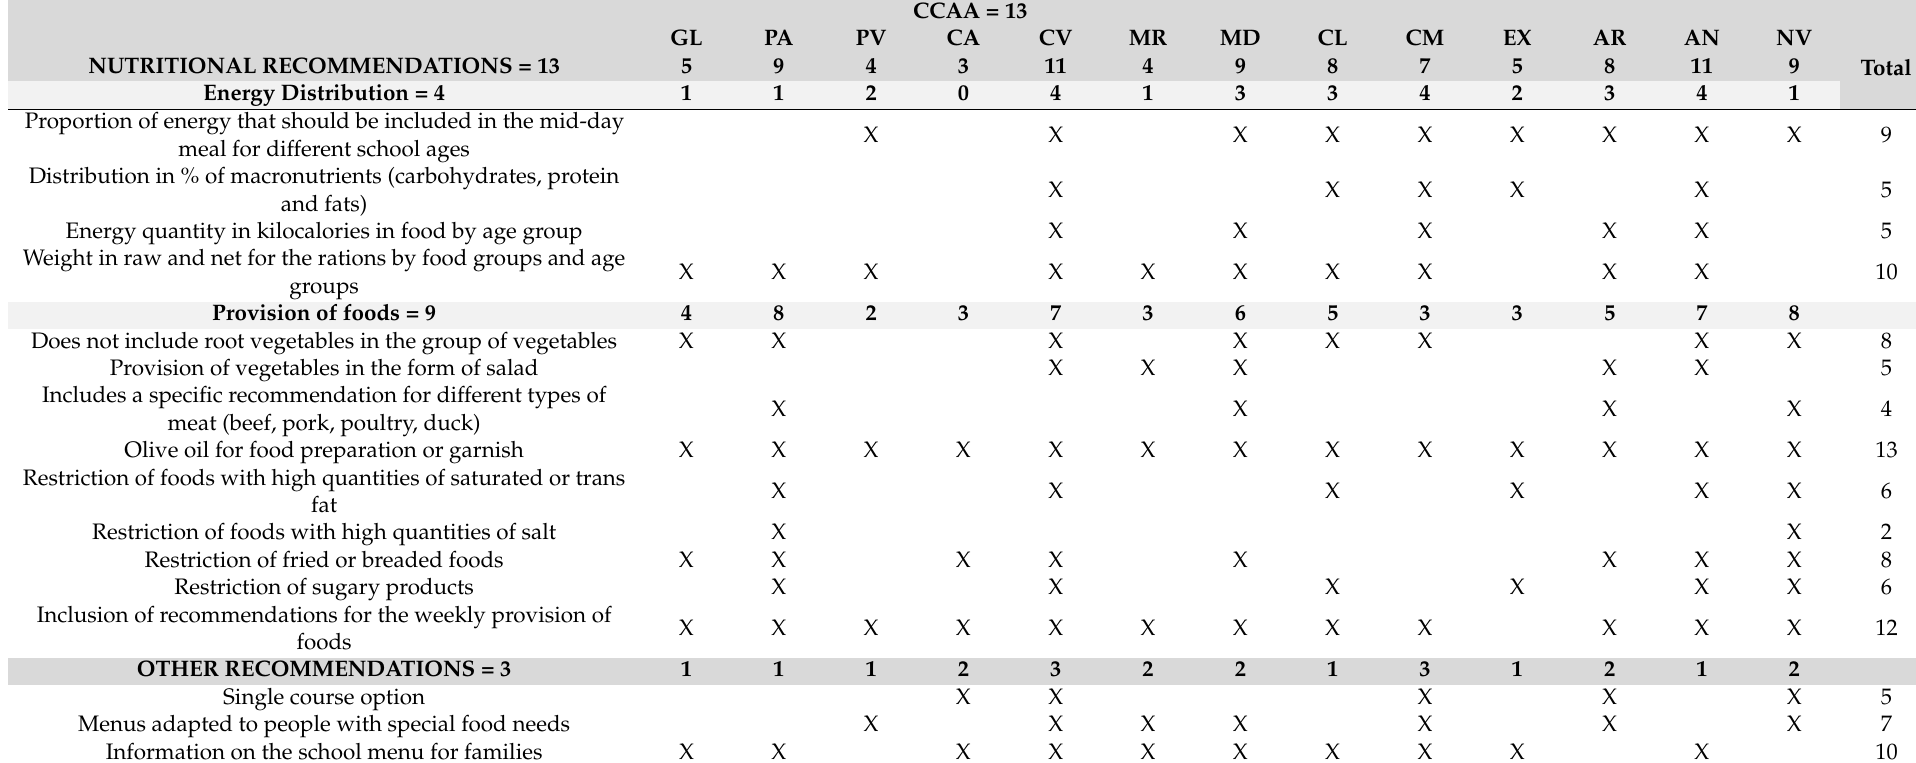
Table 1. Nutritional recommendations included in food guides for school food services by Autonomous Community (CCAA) in